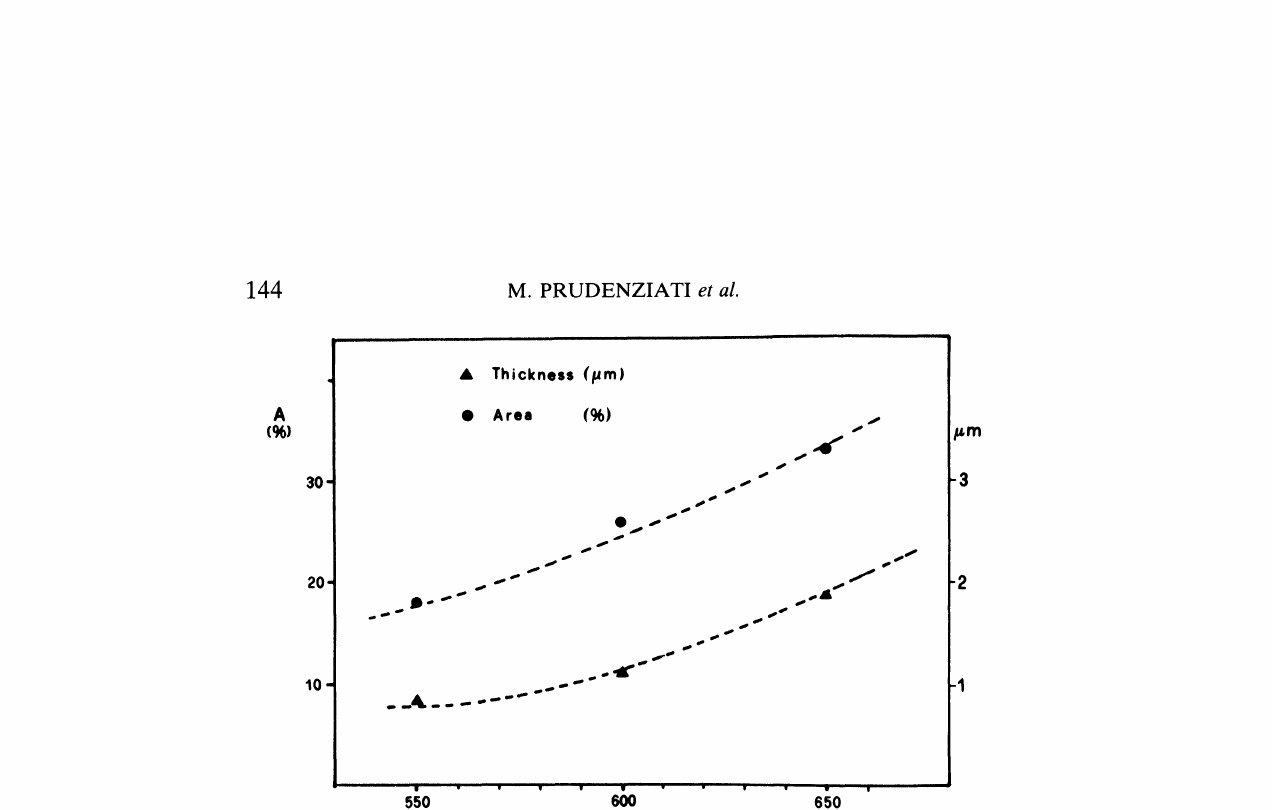
FIGURE 8 Change of heights of highest hillocks (right scale) and mean coverage area of the same hillocks (left scale) of the surface glass layer on silicon, as a function of the peak firing temperature.